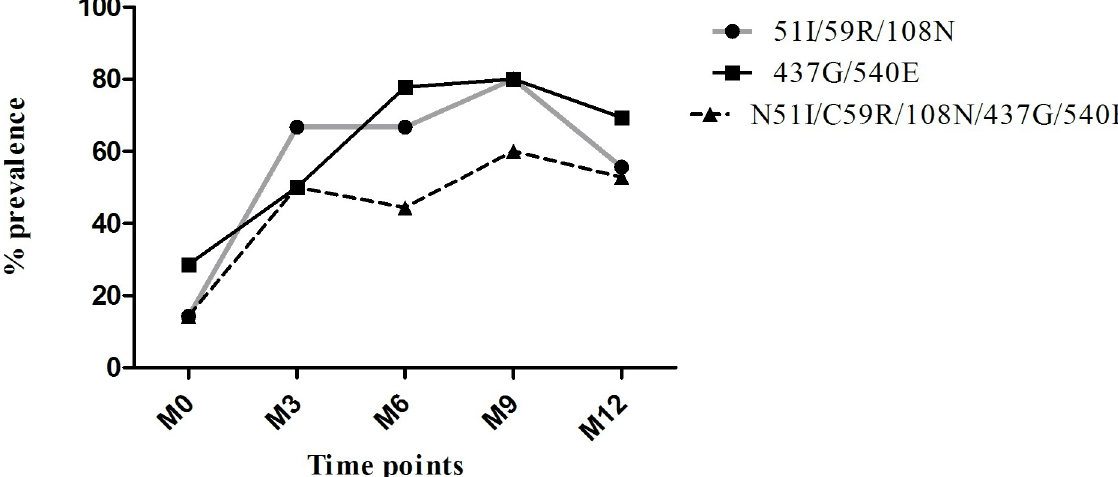
Fig 2. Temporal trends of haplotype mutations in the pfdhfr and pfdhps genes in the STOP-CTX arm. The prevalence is based on the total number of samples collected at each time point. Temporal trends shown for haplotype mutations in pfdhfr gene (51I/59R/108N), pfdhps gene (437G/540E) and both genes combined